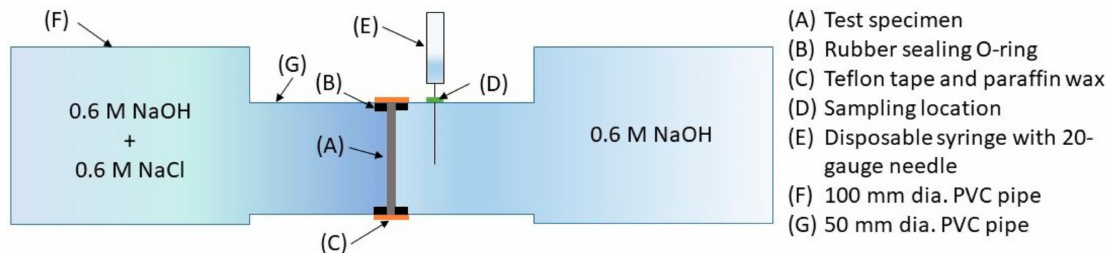
Figure 4. Schematic illustration of the chloride di ff usion testing